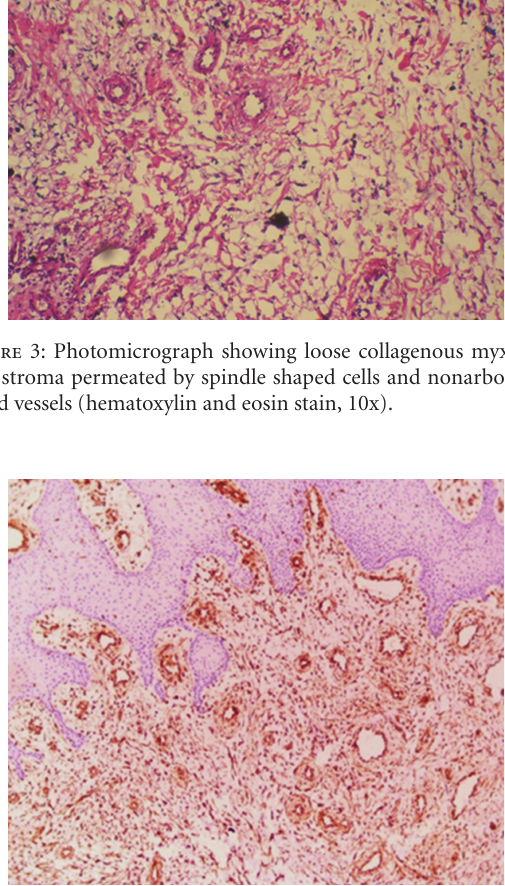
Figure 4: Many tumor cells stained strongly for vimentin